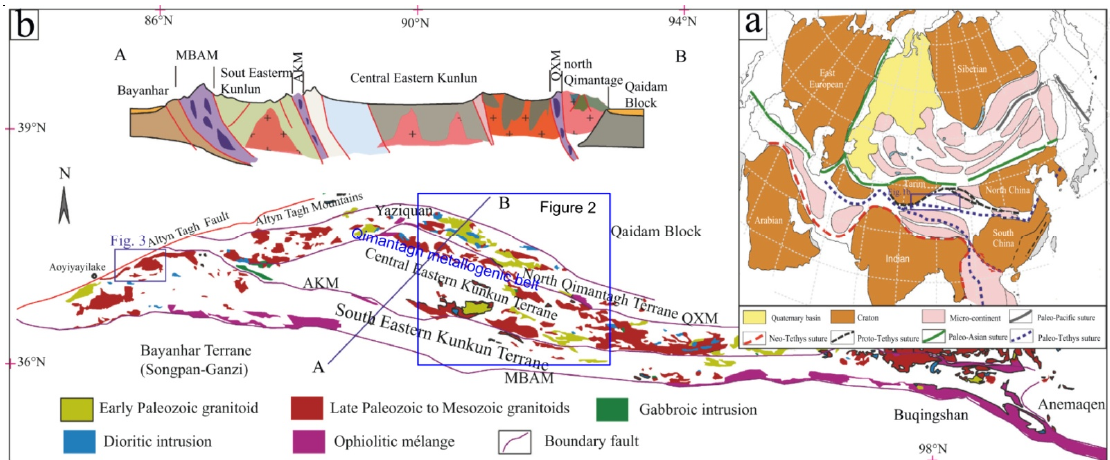
Figure 1. Tectonic setting of the East Kunlun Oregon and Qimantagh Metallogenic Belt [10,11]. ( a ) shows the location, ( b ) is tectonic map showing tectonic division, ophiolite, subduction- and collision-related metamorphic and magmatic units; inset section A-B is the schematic section of main tectonic units across the East Kunlun Orogen. QXM: Qimantagh–Xiangride mélange zone, AKM: Aqikekulehu–Kunzhong mélange zone, MBAM: Muztagh–Buqingshan–Anemaqen ophiolitic mélange zone [10].